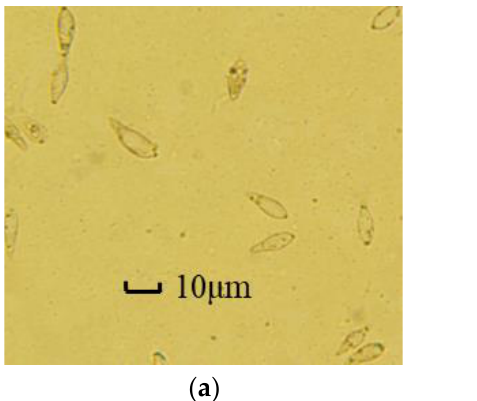
Figure 6. The experimental platform for spore enrichment.